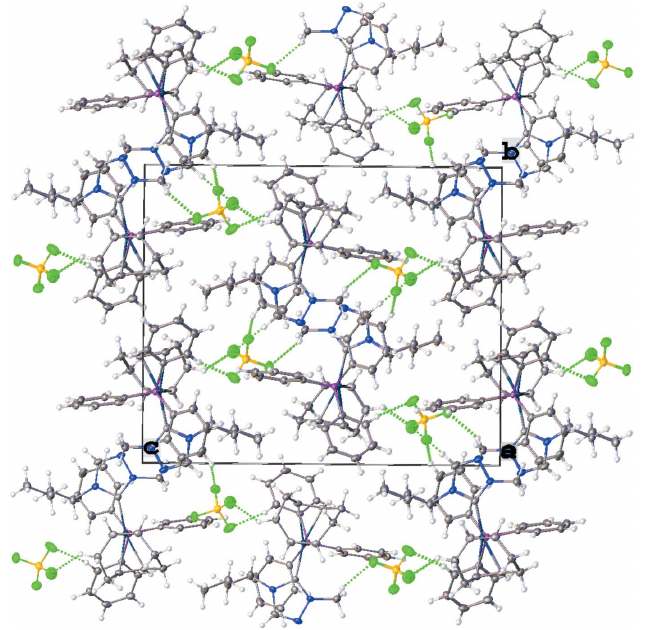
Figure 3 View of the title compound ( 4 ) showing T-shaped distorted perpendicular interactions arising from C—H (cid:2)(cid:2)(cid:2) (cid:2) (ring) interactions between a hydrogen atom on a phenyl ring (H9) and a phenyl ring (C13–C18) of triphenylphosphane. [Symmetry code: (i) (cid:3) x + 2, (cid:3) y + 1, (cid:3) z + 1].